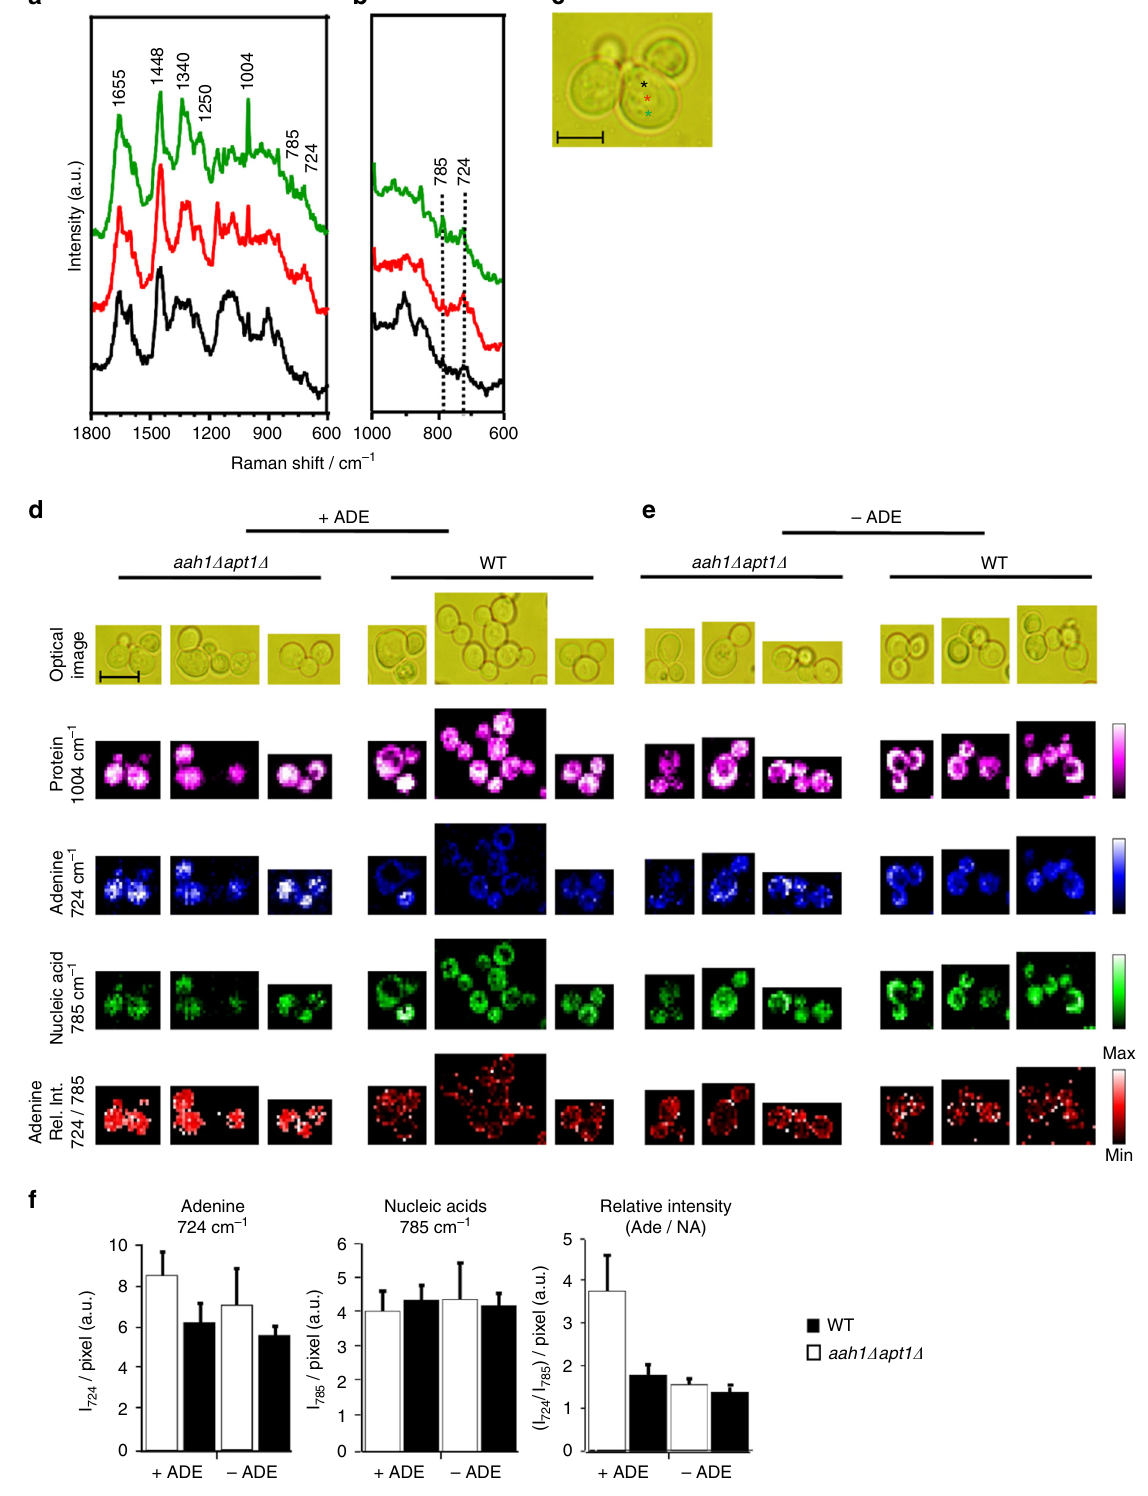
Fig. 2 In vivo Raman visualization of adenine accumulation. a – c Space-resolved Raman spectra of mutant yeast ( aah1 Δ apt1 Δ ). Whole fi ngerprint region of the Raman spectrum ( a ) and zoom in of nucleic acids and the adenine marker region (800 – 600 cm − 1 ) ( b ) are shown. The corresponding optical image is presented and the measured points are indicated using colored asterisks. Scale bar is 5 µ m ( c ). d and e Raman chemical images of the salvage mutant and wild-type yeast cells in the presence of adenine ( d ) and in the absence of adenine ( e ). Raman images of protein (1004 cm − 1 ; magenta), adenine (724 cm − 1 ; blue), nucleic acids (785 cm − 1 ; green) and the relative intensity of adenine and nucleic acids (724/785cm − 1 ; red) are presented. Corresponding optical images are included for reference. Rel. Int., relative intensity. Scale bar is 5 µ m. f Calculated average intracellular intensity from yeast cells of 724 cm − 1 per pixel, 785 cm − 1 per pixel, and relative intensity of WT and aah1 Δ apt1 Δ yeast cells. P < 0.02 (Student ’ s t -test). Values are the mean ± s.d. of three